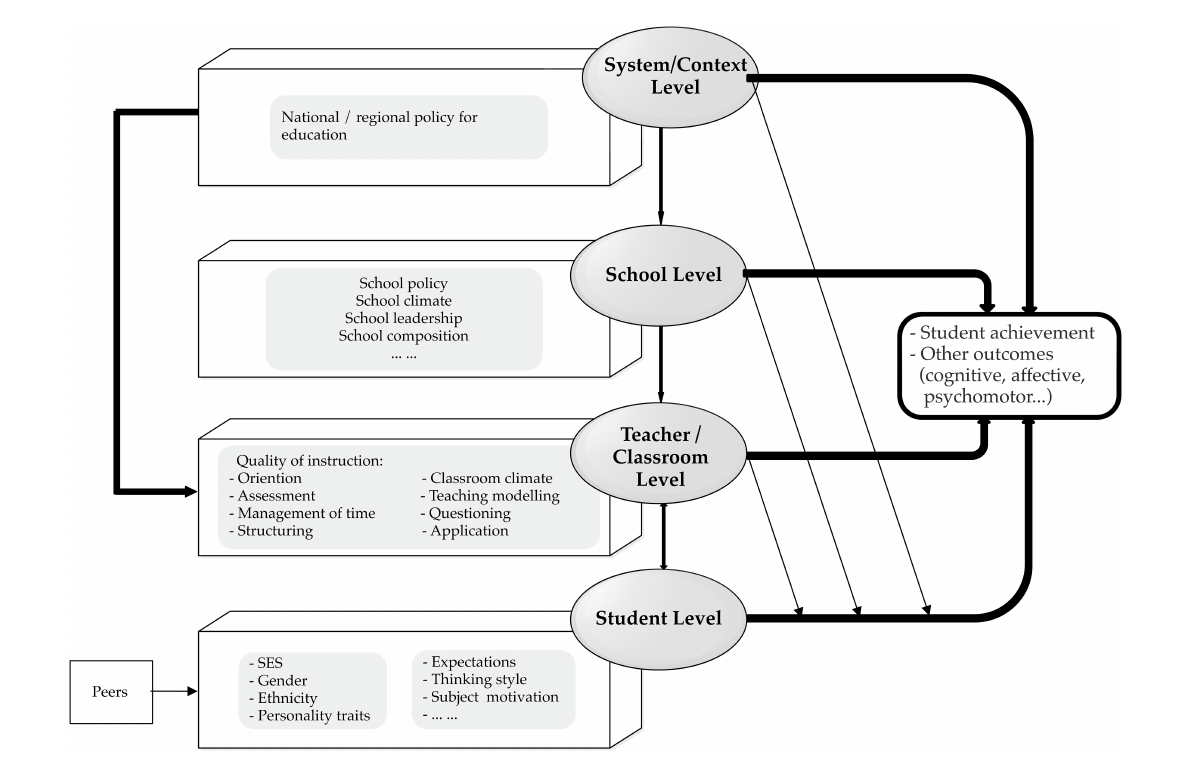
FIGURE1 The Dynamic Model of Educational Effectiveness (adapted from Creemers and Kyriakides, 2007; Kyriakides et al., 2020).